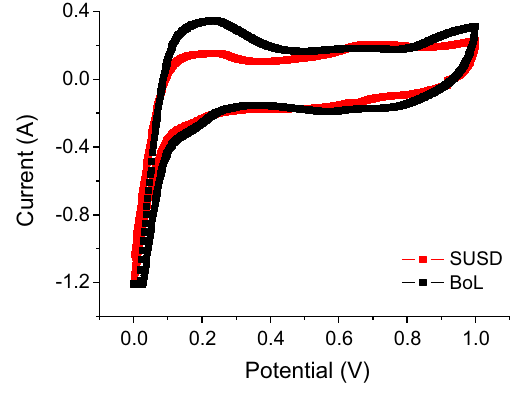
Fig. 6 Cyclic voltammetry of a fresh (BoL) and tested MEA (SUSD) measured at 30 °C, 100% RH and a voltage range of 0.015–1.00 V and a sweep rate of 30 mVs −1 . The anode and cathode were supplied with hydrogen and nitrogen